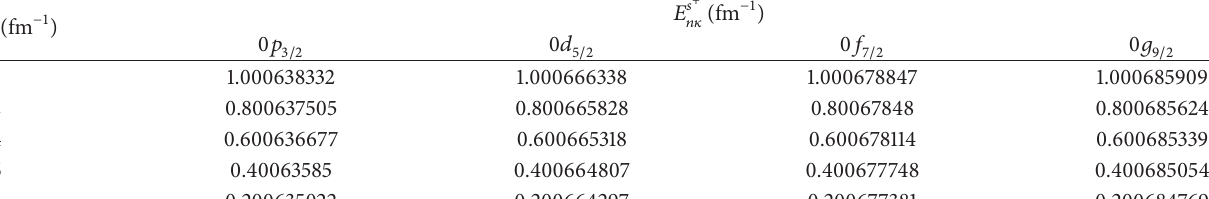
Table 6: Energies in the spin symmetry limit for 𝐴 𝑠 = −0.5 , 𝑎 𝑠 = 0.02 , 𝑏 𝑠 = 0.01 , and 𝐶 𝑠 = 1 fm −1 .